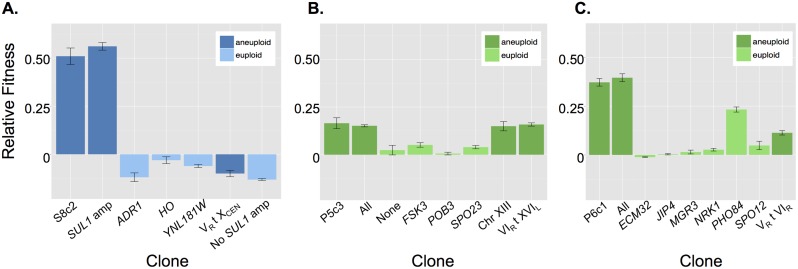
Aneuploidy variably affects fitness of evolved clones.The individual fitness effects of point mutations and aneuploid events were determined for all mutations identified in the evolved clones S8c2 (A), P5c3 (B), and P6c1 (C). The supernumerary chromosome(s) in each clone are labeled by their identifying translocation or, in the case of the chromosome XIII disomy, as “Chr XIII.” Aneuploid and euploid clones are color-coded according to the legend. As described in the text, “All” for P5c3 and P6c1 and “None” for P5c3 represent backcrossed segregants that contain all or none of the mutations present in the original evolved clone. “No SUL1 amp” for S8c2 is a backcrossed segregant that contains all the mutations identified in S8c2 except for the SUL1 amplicon. Raw data can be found in S2 Table.